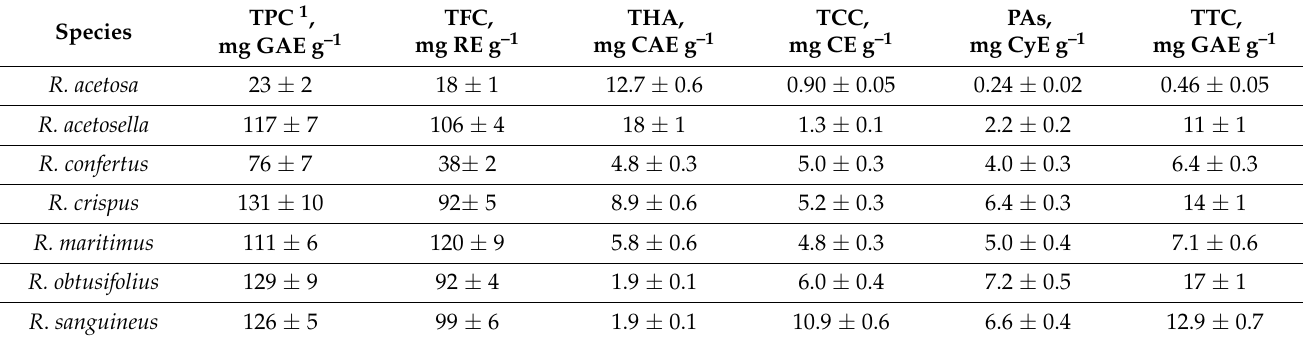
Table 1. Content of some groups of phenolic compounds in the leaves of different Rumex